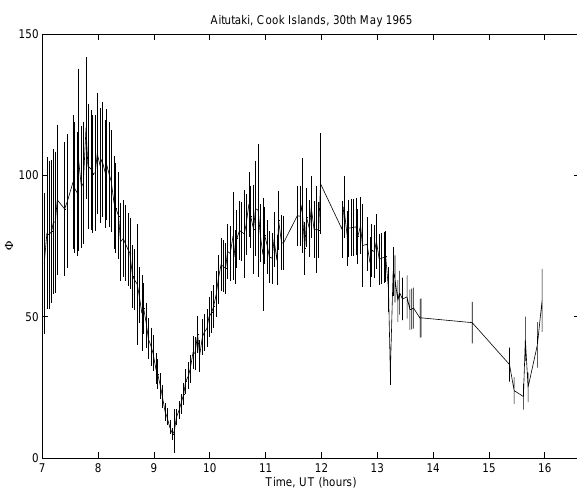
Fig. A2. The variation of 8 during the eclipse of 20 May 1947 at Bocaiuva, Brazil as calculated using Eq. (2) and the data shown in Fig. A1.